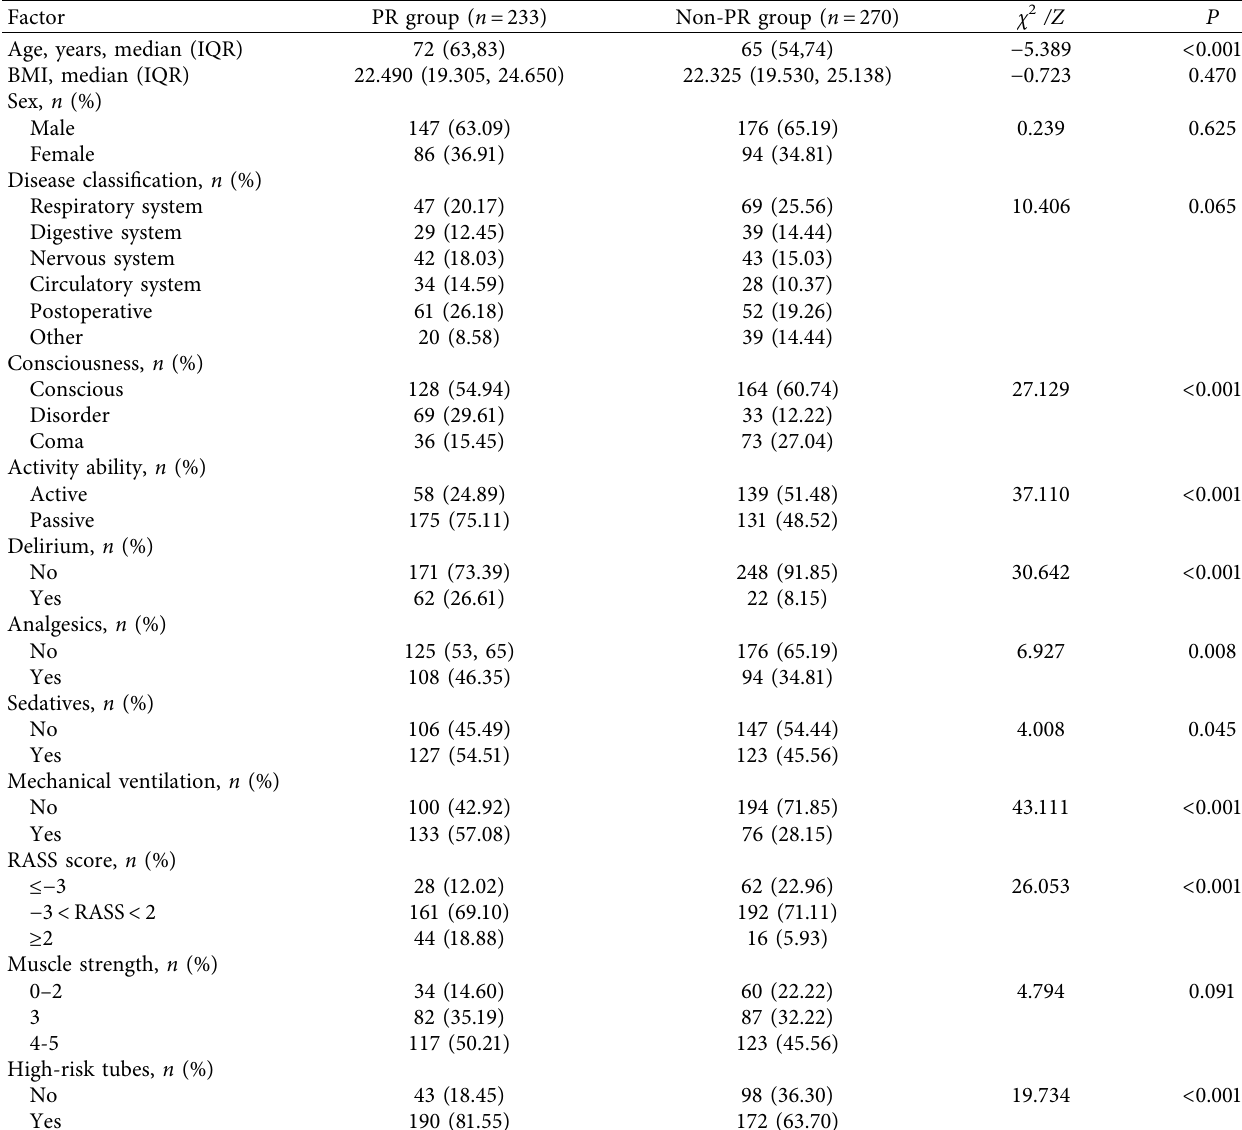
Table 1: Univariate analysis of physical restraint in ICU